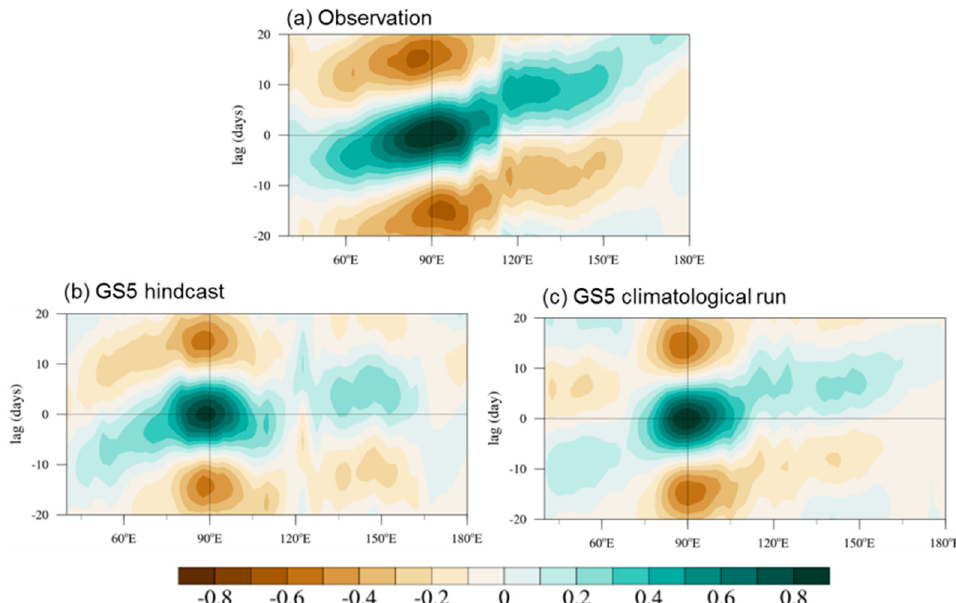
Figure 5. Lagged correlation of 20–70 days filtered precipitation averaged over 10° S–10° N from ( a ) observation, ( b ) the GS5 hindcast, and ( c ) the GS5 climatological run. The precipitation over the equatorial Indian Ocean (10° S–10° N, 80°–100° E) during boreal winter (NDJFMA) is used as a reference. Horizontal (vertical) black line represents zero lag (longitude of 90° E).